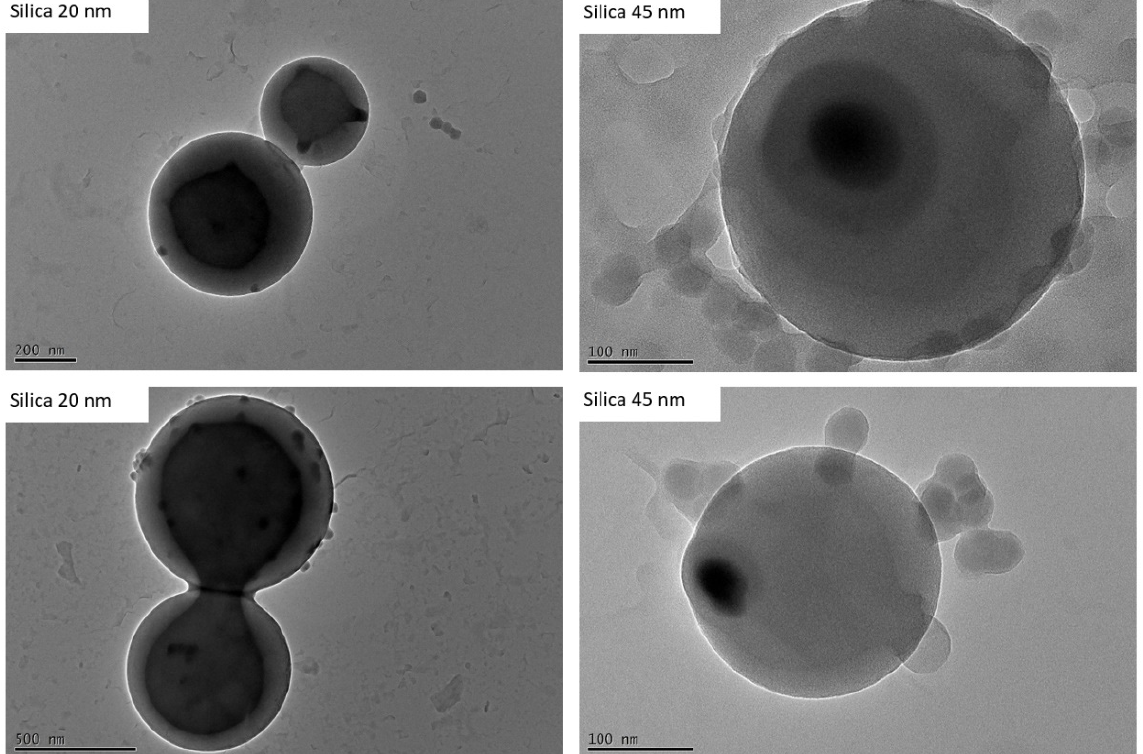
Figure 11. Exemplary TEM images of encapsulation experiments of APTES-modified silica particles with PS-b-PAA vesicles. The image on the left shows 20 nm silica particles, and the one on the right shows 45 nm silica particles.